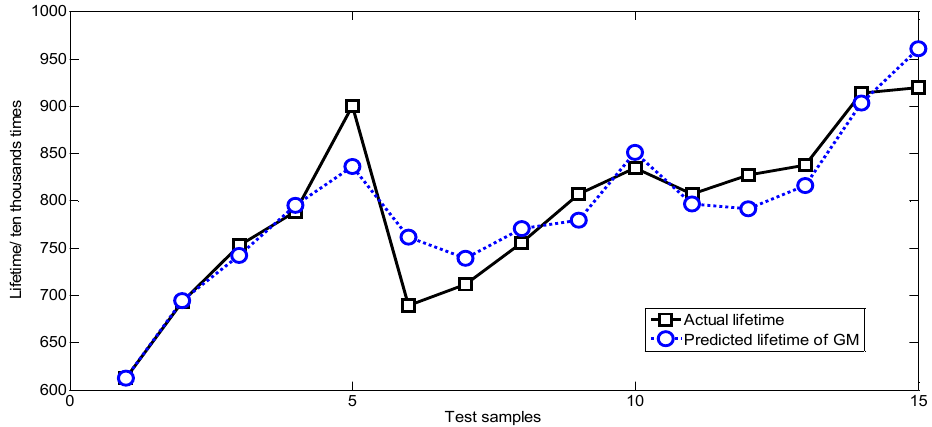
Figure 5. The comparison of prediction value using GM (1, 5) with actual value.